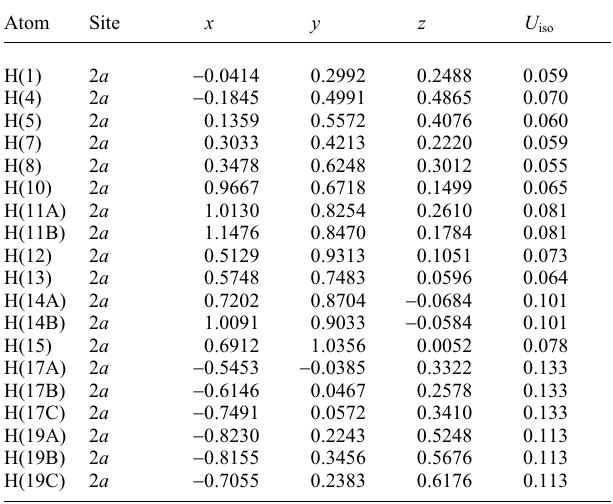
Table 2. Atomic coordinates and displacement parameters (in Å 2 )